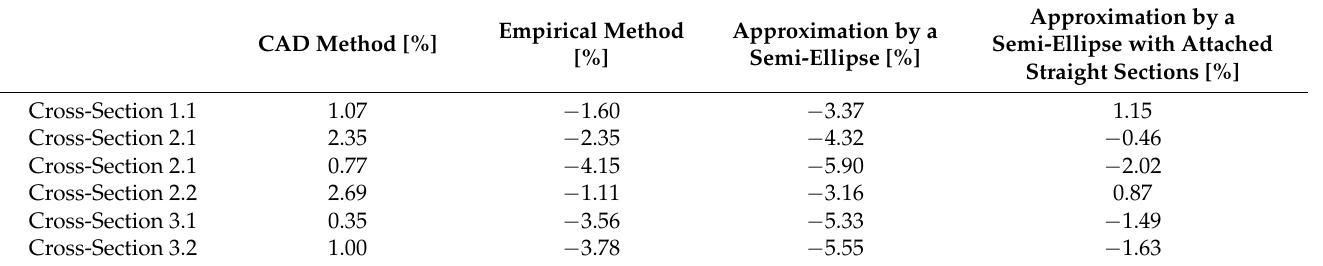
Table 4. Percentage differences for each cross section, calculated by four methods compared with the scanning method.